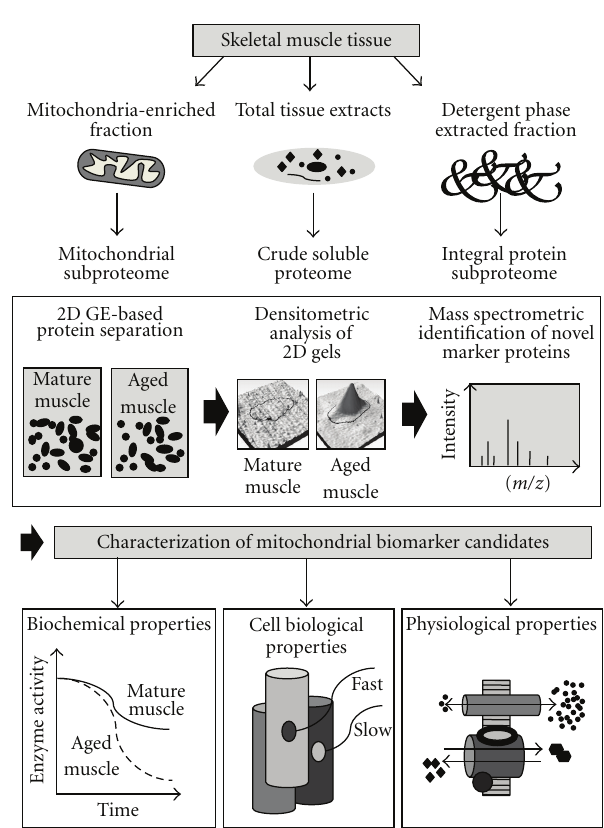
Figure 2: Flowchart of the proteomic workflow to identify and characterize novel mitochondrial markers involved in sarcopenia of old age. Shown are the various steps involved in the high- throughput proteomic screening of tissue specimens, including sample preparation, gel electrophoretic separation, densitometric analysis, and mass spectrometric identification of new candidate